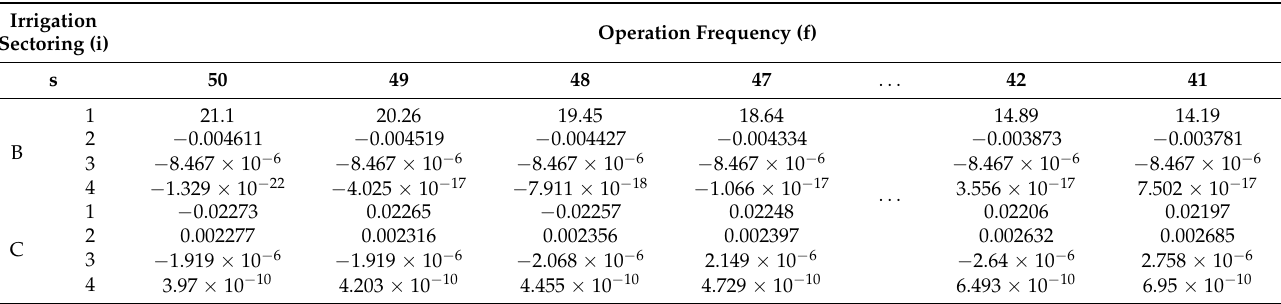
Figure 6. Schematic diagram of experimental system construction. Table 4. The polynomial regression coefficient of the pump at the experimental site, since B i,f and C i,f have two variables, is converted into a table of different coordinates for description, irrigation sectoring (i), and operation frequency (f).